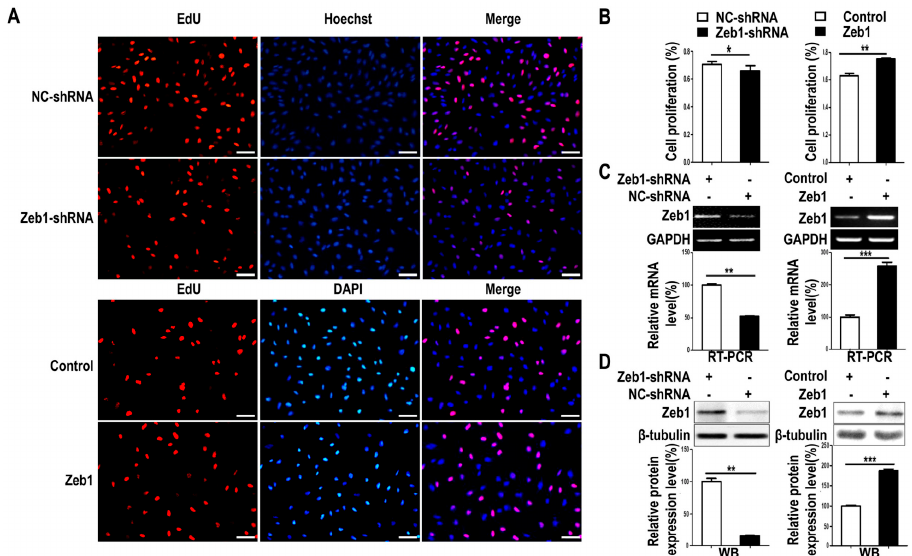
Figure 2. Knock-down of Zeb1 inhibits mK3 cell proliferation while overexpression of Zeb1 promotes it. ( A ) Proliferating mK3 cells were labeled with EdU (red) and nucleuses of the whole cells were stained with DAPI or hoechst (blue). The cells were 48 h post-treated with vectors of overexpression or target shRNA or the respective control vectors. The images present were taken by fluorescent microscopy (200×) with a scale bar of 50 μ m and the red and blue images were merged to the purple ones; ( B ) EdU positive percentage (EdU %) were quantified. Results were displayed as mean ± SD ( n = 3). * p < 0.05, ** p < 0.01, *** p < 0.001 negative control vectors; ( C , D ) The RT-PCR and western-blot showed the significant efficiency of Zeb1 overexpression and knock-down. The expression was calculated by scanning gray in Image J software normalized to the internal mRNA control GAPDH or protein control β -tubulin. The result was shown with error bars representing mean ± SD ( n = 3). * p < 0.05, ** p < 0.01, *** p < 0.001.